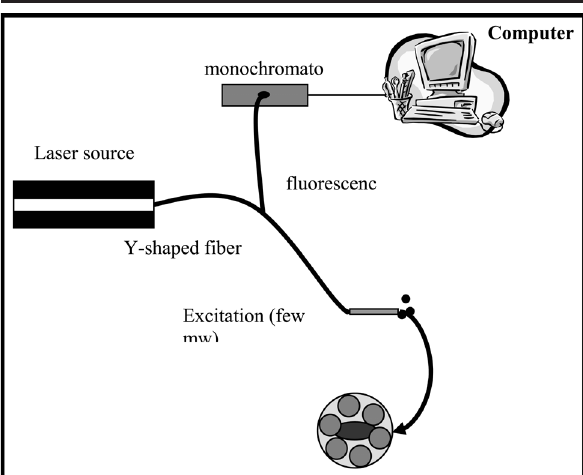
FIGURE 6 - Graph comparing the reduction of the mitochondrial respiratory control ratio (RCR) and hepatic fluorescence in the CS group, during the 12 hours after